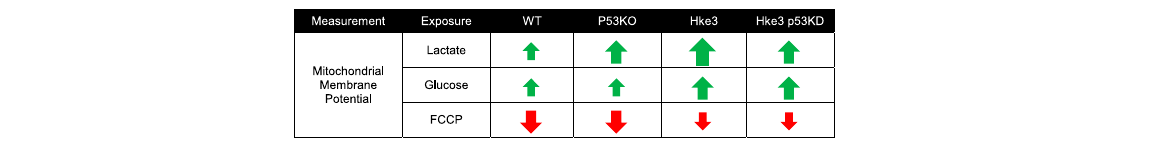
TABLE 3 Summary of mitochondrial membrane potential